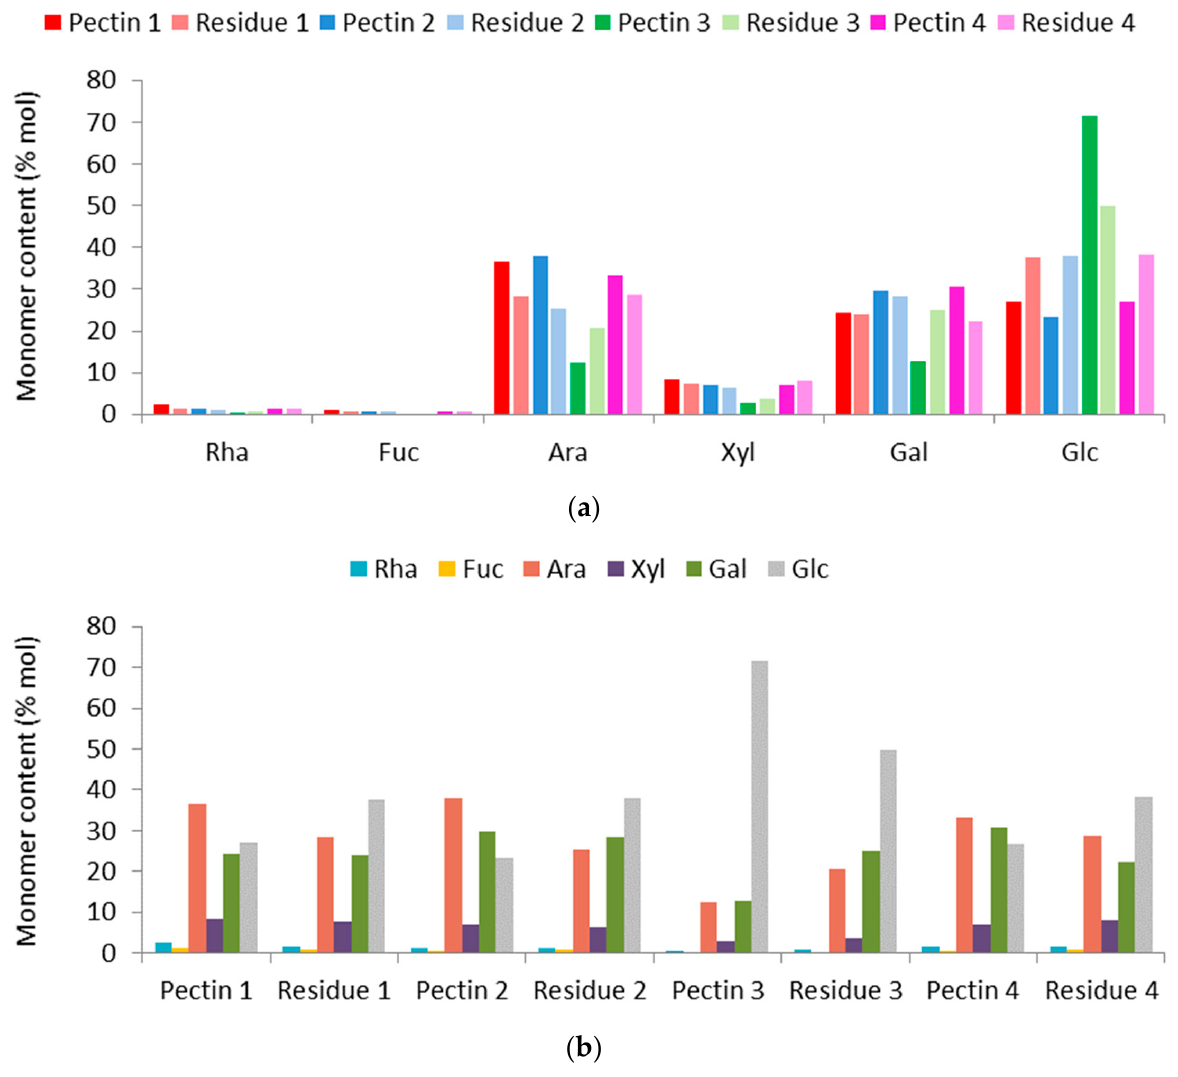
Figure 3. Distribution of neutral monosaccharides; pectins in darker tones and residues in lighter tones ( a ). Composition of neutral pectin sugars and extraction residues ( b ).